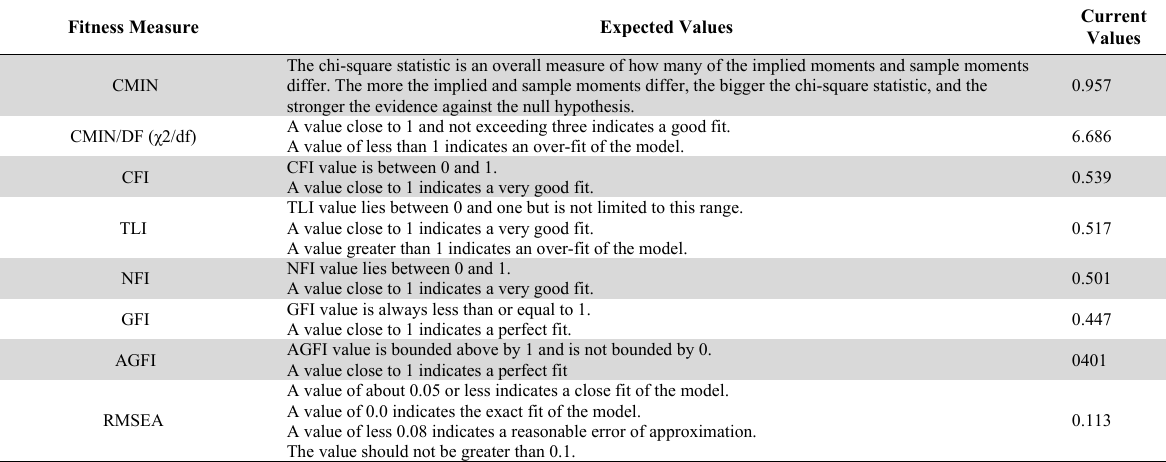
Measure of fits Fitness Measure